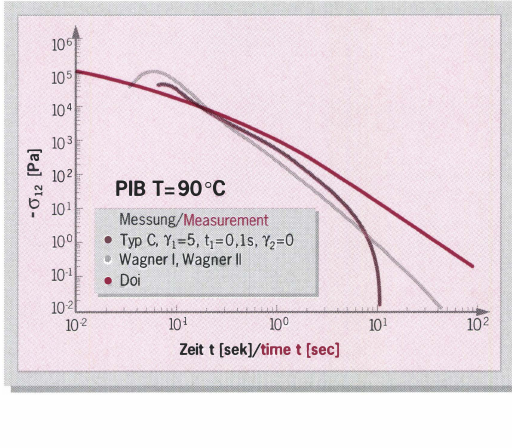
Fig. 3: cr 12 for strain sequence C at t1 = 0.1s